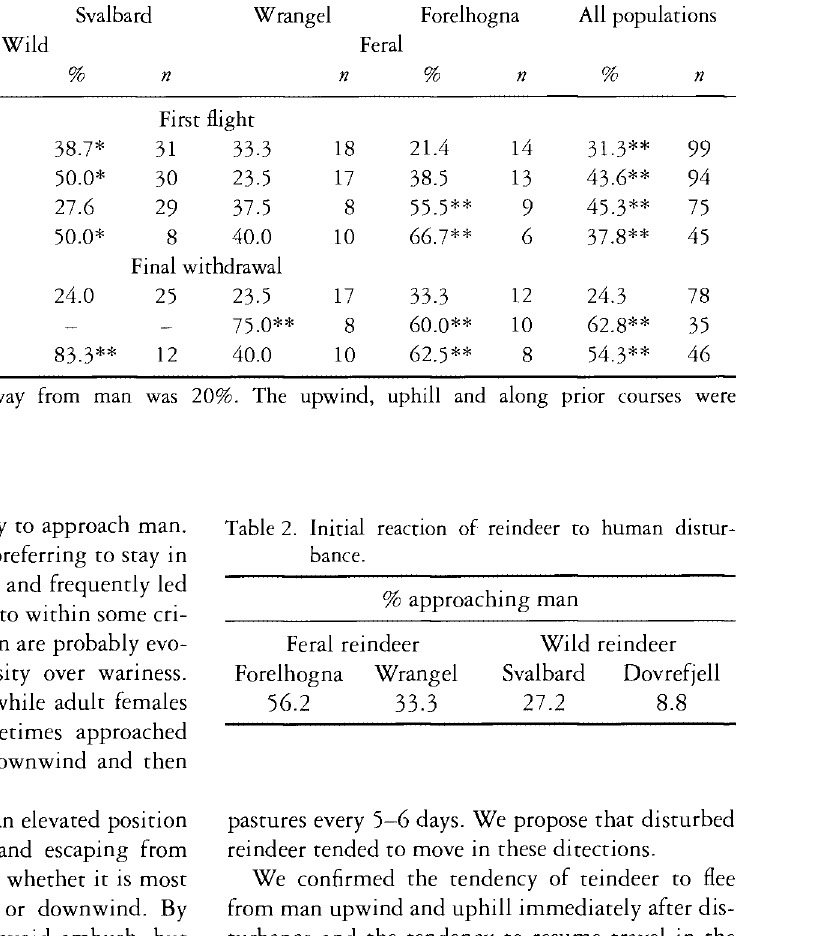
Table 1. Routes of first flight and final withdrawal of reindeer after human disturbance. Direction 2